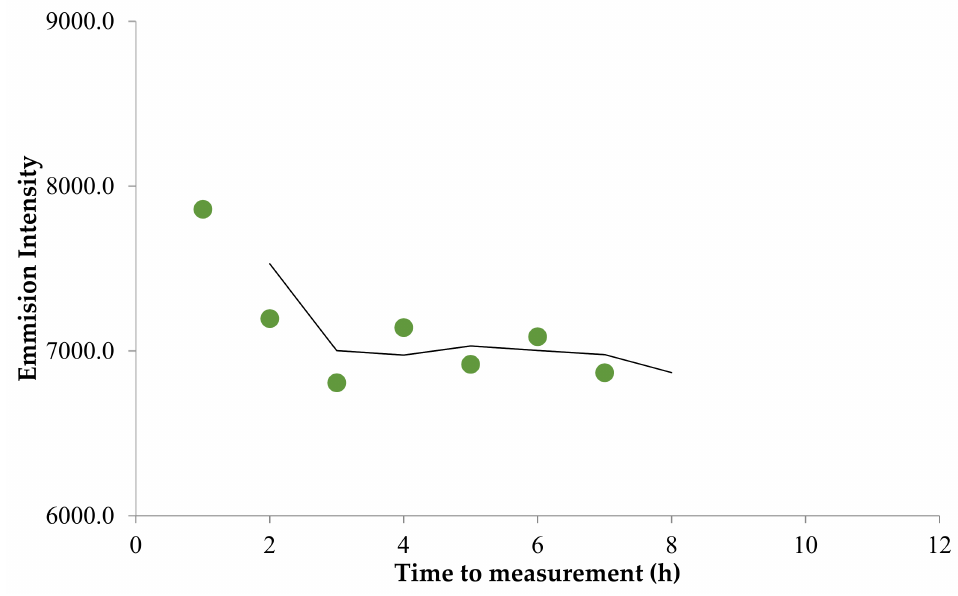
Figure 3. Stability test of the solution.